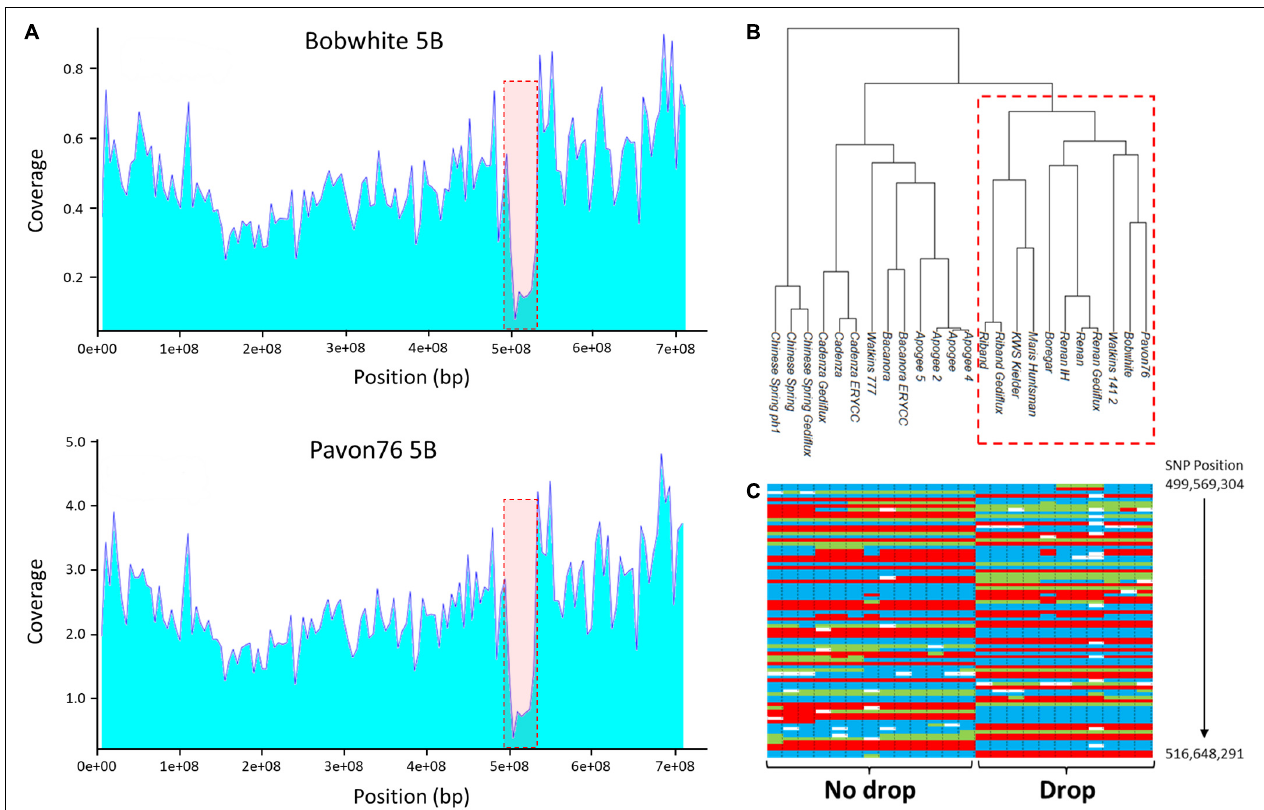
FIGURE 2 | (A) Average depth of coverage for chromosome 5B in the accessions ‘Bobwhite’ and ‘Pavon 76’; both show a drop in read coverage on the long arm at approximately position 490,000,000–540,000,000. (B) Dendrogram based on the 1,749 Axiom markers mapped to chromosome 5B; the 8 varieties (‘Bobwhite’, ‘Boregar’, ‘KWS Kielder’, ‘Maris Huntsman’, ‘Pavon 76’, ‘Renan’, ‘Riband’, and ‘Watkins 141’) with the drop in read coverage cluster. (C) A sample of the SNP calls across the interval 499,569, 304–534,345,241 highlighting the difference between the two groups (blue and red are the alternative homozygote calls; green indicates heterozygote